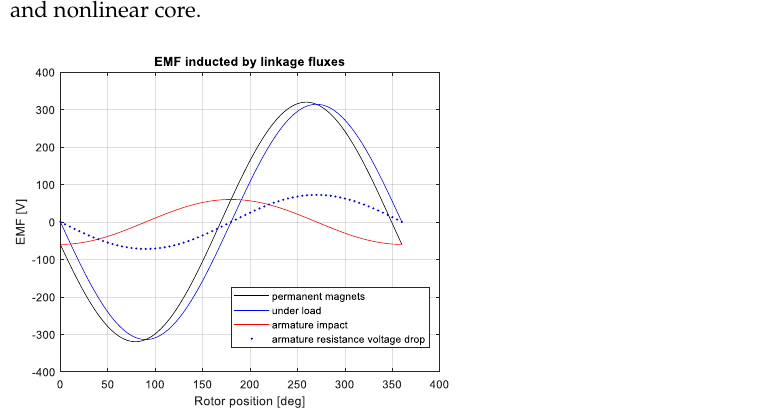
Figure 9. First harmonics of EMF induced by linkage fluxes in the proposed flat core design.